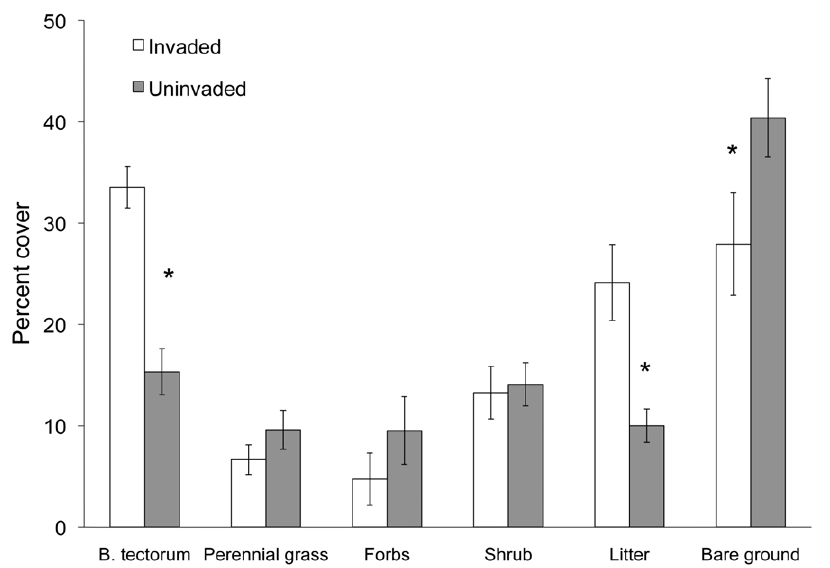
Figure 1. Community composition in invaded and uninvaded populations. Percent cover of B. tectorum , other plant functional groups, litter, and bare ground in invaded and uninvaded populations averaged over all four sampling locations. Bromus tectorum cover ranged from 2% in uninvaded areas to 40% in invaded areas. Asterisk indicates significant differences between invaded and uninvaded communities ( P , 0.05).